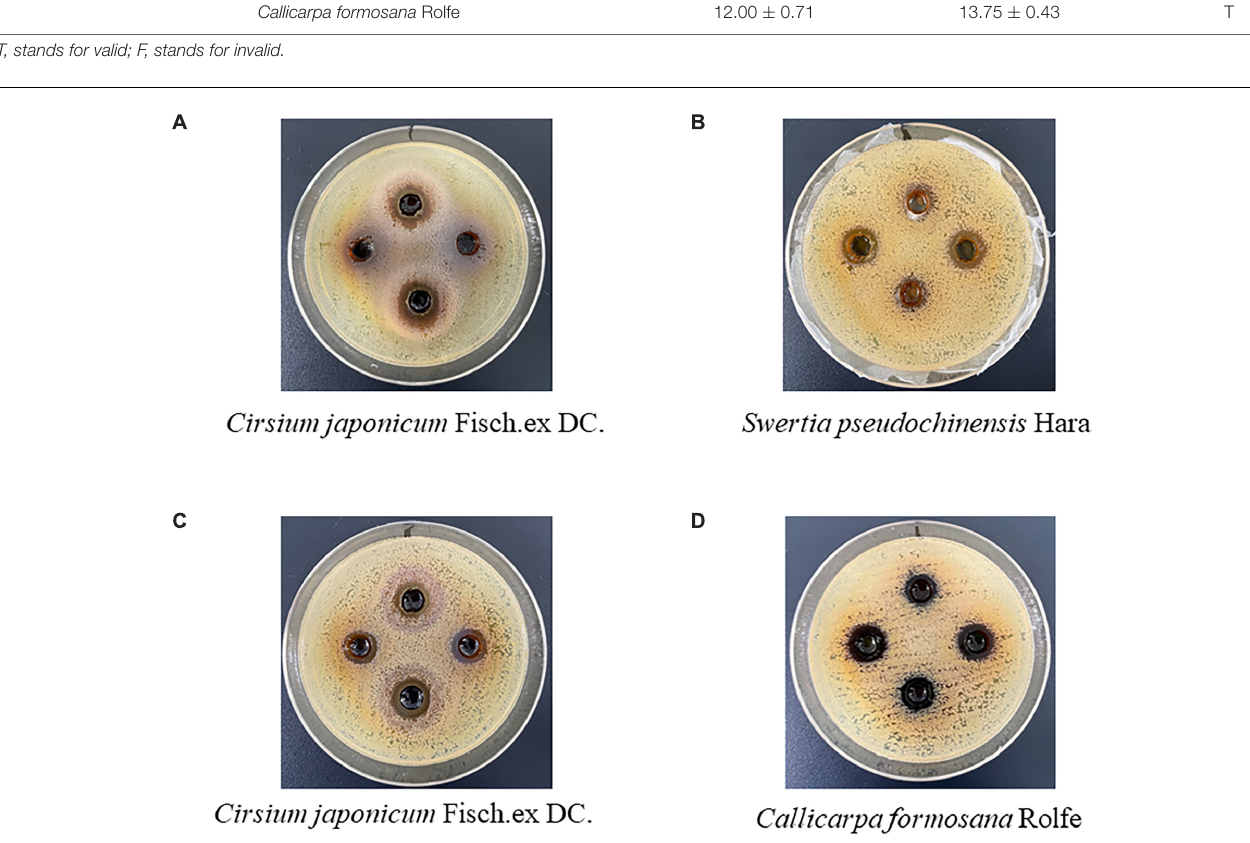
FIGURE 10 | Inhibition zone of TCMs extract against E. coli and S. aureus . (A) Inhibition zone of TCMs extract on E. coli . (B–D) Inhibition zone of TCMs extract on S. aureus . The water extract was added to the up and down holes, and the ethanol extract was added to the left and right holes.